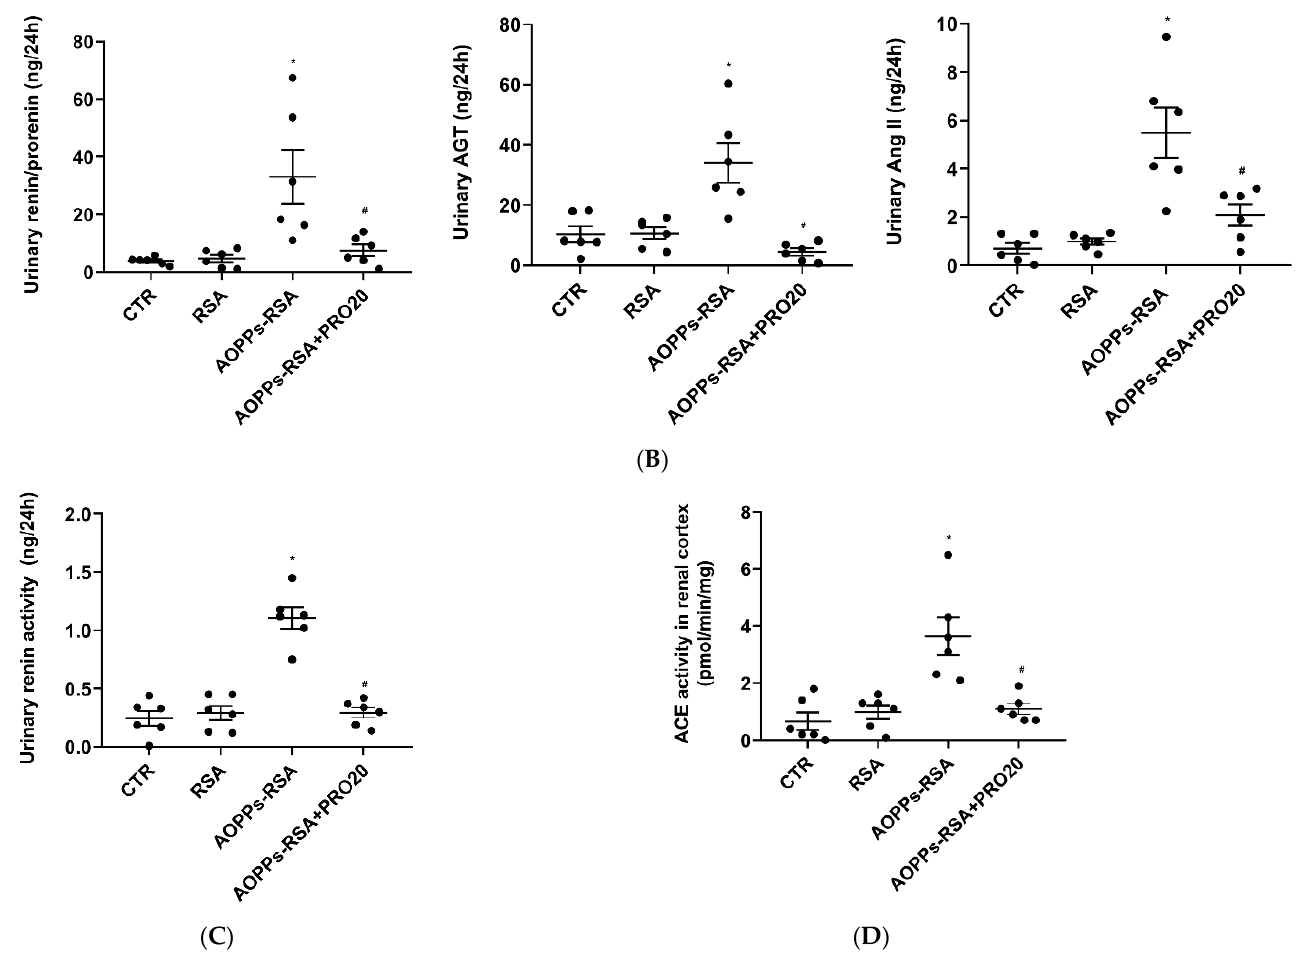
Figure 6. Analysis of the other intrarenal components of the RAS. Notes: ( A ) mRNA levels of REN , AGT , and ACE were determined by using RT-qPCR. All values were normalized against GAPDH expressions. ( B ) ELISA test was used to quantify urinary renin/prorenin, AGT, and Ang II levels. ( C ) Urinary renin activity. ( D ) ACE activity in renal cortex. Results are presented as mean ± SEM. There were 6 rats per group. * p < 0.05, compared to the CTR group; # p < 0.05, compared to the AOPPs-RSA group. RAS: renin-angiotensin system; REN: renin; AGT: angiotensinogen; ACE: angiotensin-converting enzyme; Ang II: angiotensin II.